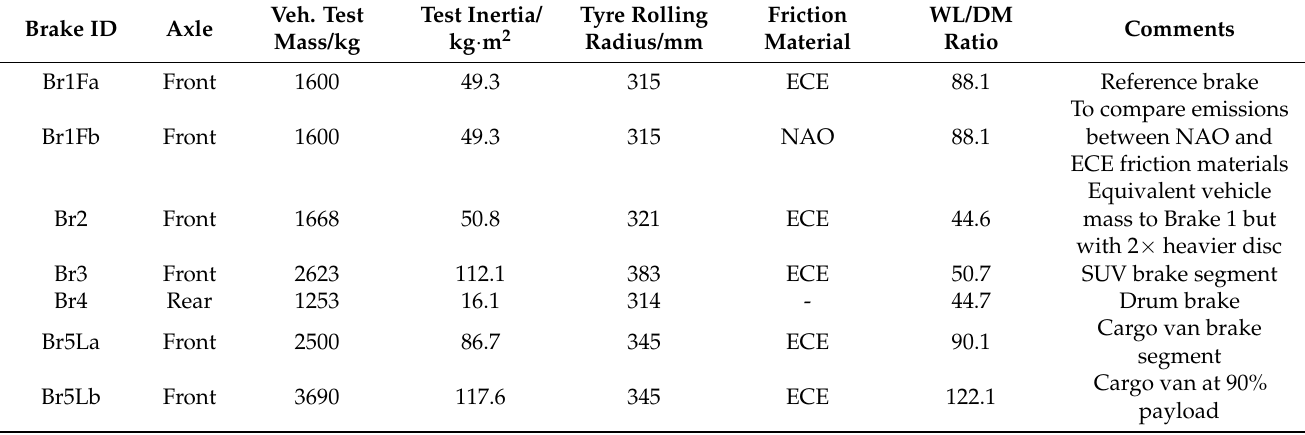
Table 1. Characteristics of tested brakes. WL/DM = wheel load/disc mass. ECE refers to European performance brake